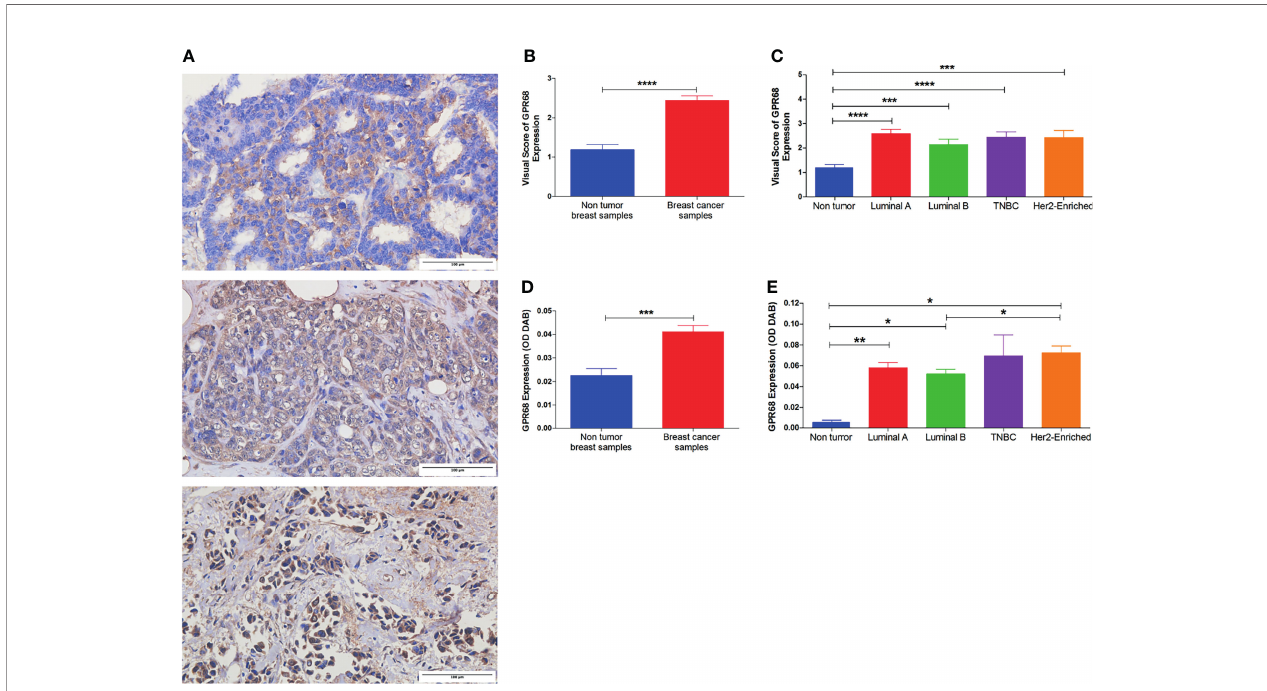
FIGURE 4 | Immunohistochemical assessment of GPR68 expression in paraf fi n-embedded breast cancer tissues. (A) Microscopic images showing various degrees of intensity: mild, moderate, and strong GPR68 expression. Images were captured at x400 magni fi cation, with a scale bar representing 100 m m. Brown/DAB staining denotes GPR68 expression. (B) Immunoreactive scoring of GPR68 expression in immunohistochemical staining of BC tissues compared to non-tumor tissues. (C) GPR68 expression according to immunoreactive scores between the different molecular subtypes of breast cancer patients. (D) Semi-quantitative assessment of GPR68 expression in breast cancer patients compared to non-tumor breast tissues, by calculating the optical density of DAB substrate using IHC toolbox-Image J. (E) Semi-quantitative assessment of GPR68 expression across the different molecular subtypes of breast cancer patients. *p<0.05, **p<0.01, ***p<0.001,